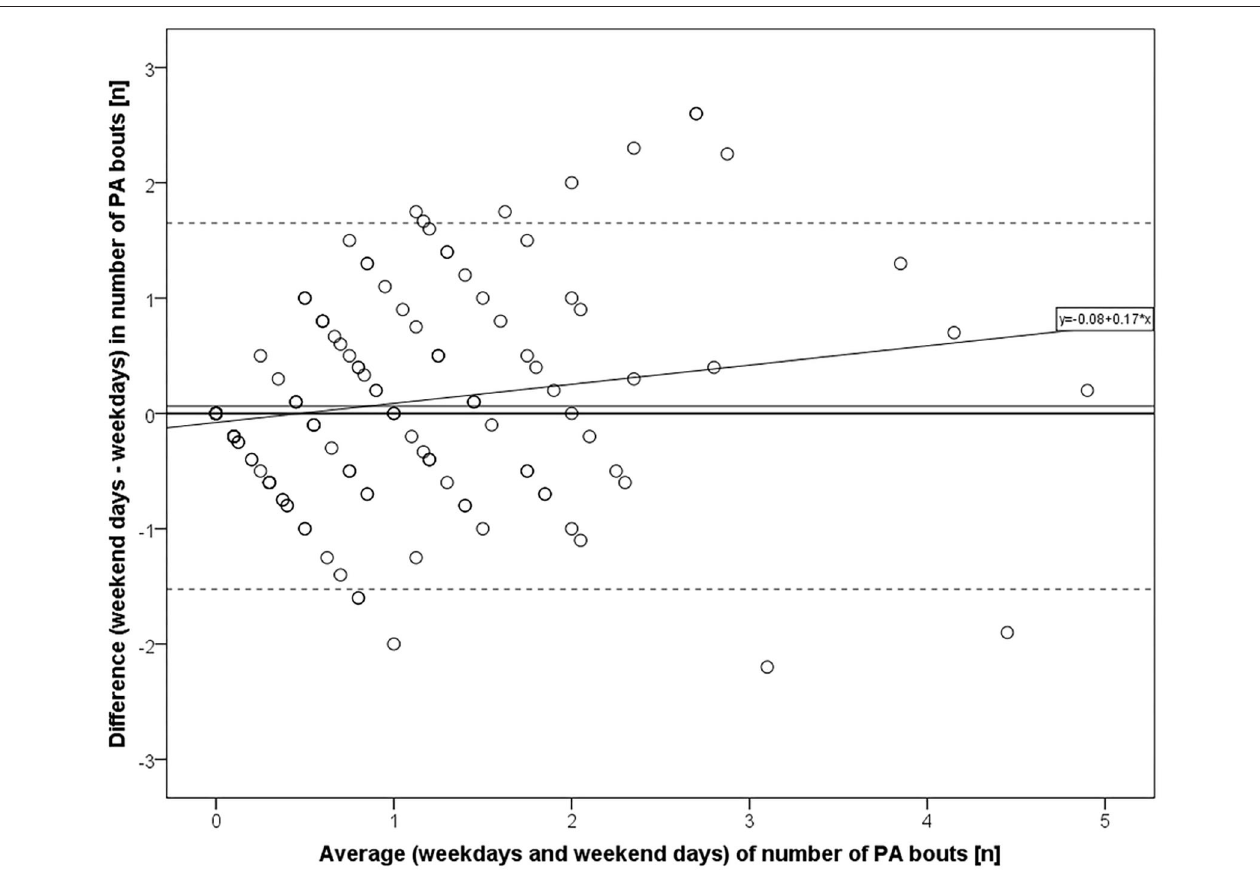
FIGURE 1 | Bland-Altman plot for number of PA bouts on weekend days vs. weekdays ( n = 167). Mean difference with 95% confidence intervals and regression line ( R 2 = 0.036, p = 0.014 for β ).